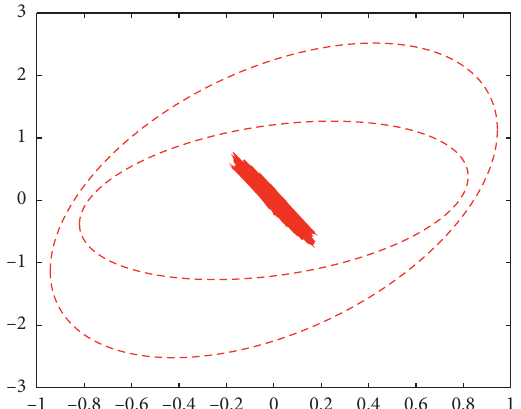
Figure 3: The ellipsoidal bound I and state trajectory of system (58) for Case 2.